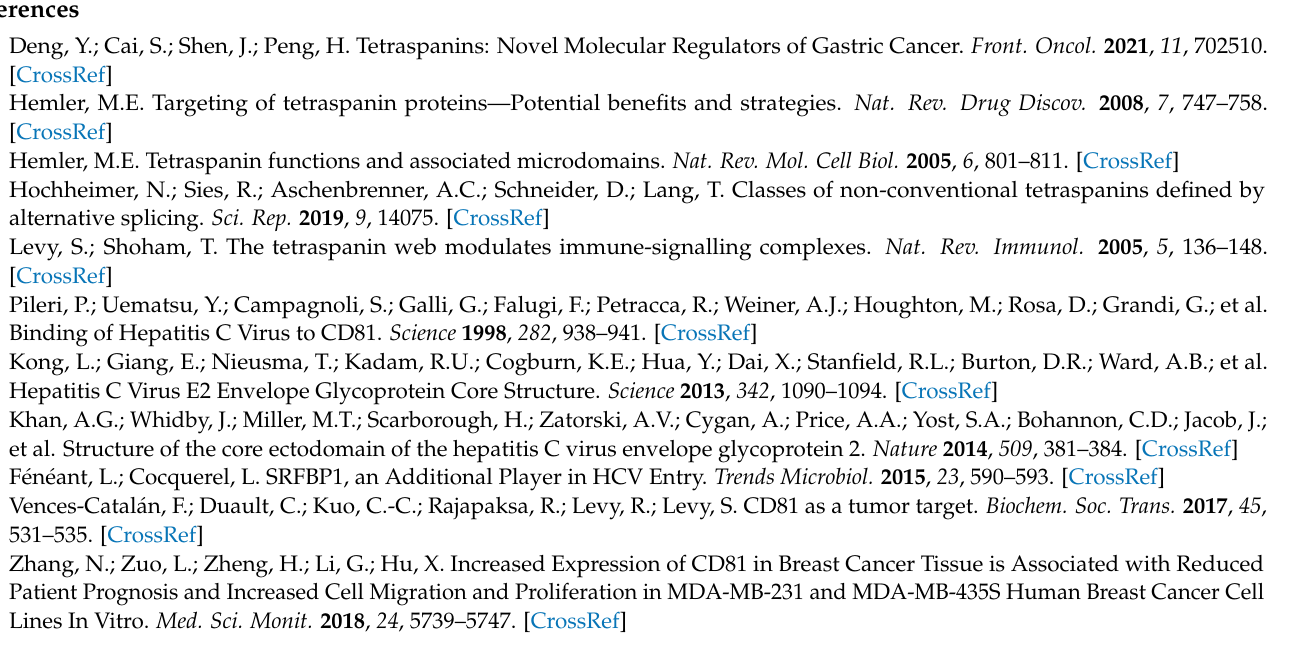
Int, intracellular. Figure S8. Protein-peptide complex structure of P152 and CD81 protein predicted by MDockPeP server [22]. (A) Protein-peptide complex structure of P152 and CD81 protein. (B) Surface representation of the molecular docking. (C) Zoomed view of the molecular docking. LEL, large extracellular loop. SEL, small extracellular loop. Ext, extracellular. Int, intracellular. Figure S9. Protein-peptide complex structure of P153 and CD81 protein predicted by MDockPeP server [22]. (A) Protein-peptide complex structure of P153 and CD81 protein. (B) Surface representation of the molecular docking. (C) Zoomed view of the molecular docking. LEL, large extracellular loop. SEL, small extracellular loop. Ext, extracellular. Int, intracellular. Table S2. Docking energy scores of P152 for CD81, EPCAM, and CD44 assessed by HPEPDOCK: a web server for blind peptide-protein docking based on the hierarchical algorithm [23]. Table S3. Docking energy scores of P152 and its scrambled sequences for CD81 assessed by HPEPDOCK: a web server for blind peptide-protein docking based on the hierarchical algorithm [23]. Figure S10. (A) MS spectrogram and (B) HPLC chromatogram of P152-1. Figure S11. (A) MS spectrogram and (B) HPLC chromatogram of